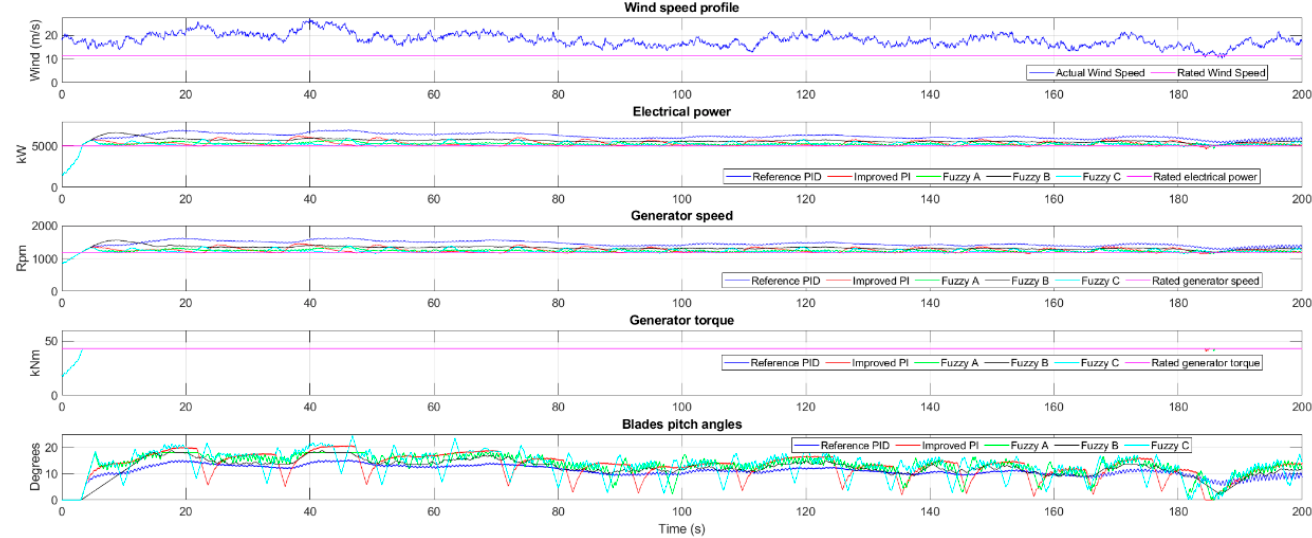
Figure 16. Comparison of the evaluated controllers for a wind profile of 18 m/s. Table 7. Indexes for simulations with wind profile 1 (13 m/s A). Table 9. Indexes for simulations with wind profile 3 (18 m/s